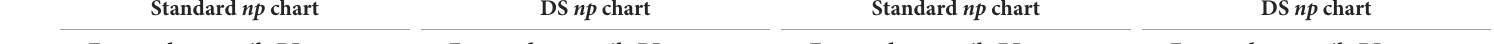
TABLE 3 Performance of the DS np and standard np charts with MRL 0min = 200 and 370.4. MRL 0 min = 200 MRL 0 min = 370.4 Standard np chart DS np chart Standard np